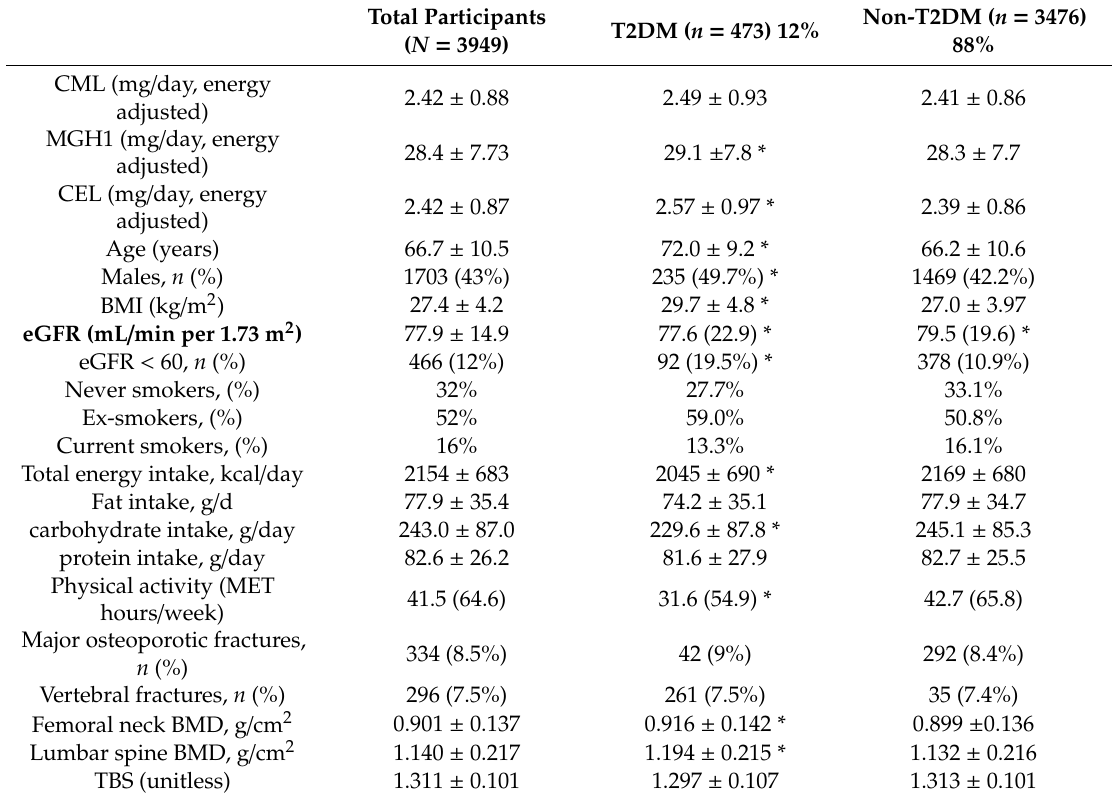
Table 1. Demographic and clinical characteristics of total participants with complete data and a comparison between subjects with (T2DM) and without type 2 diabetes mellitus (non-T2DM).